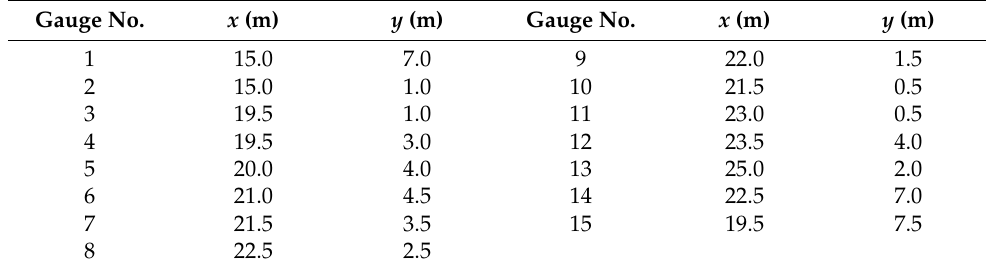
Figure 10. Setup of breakwater and wave gauges of Lara et al.’s experiments [36]. Table 3. Locations of wave gauges.